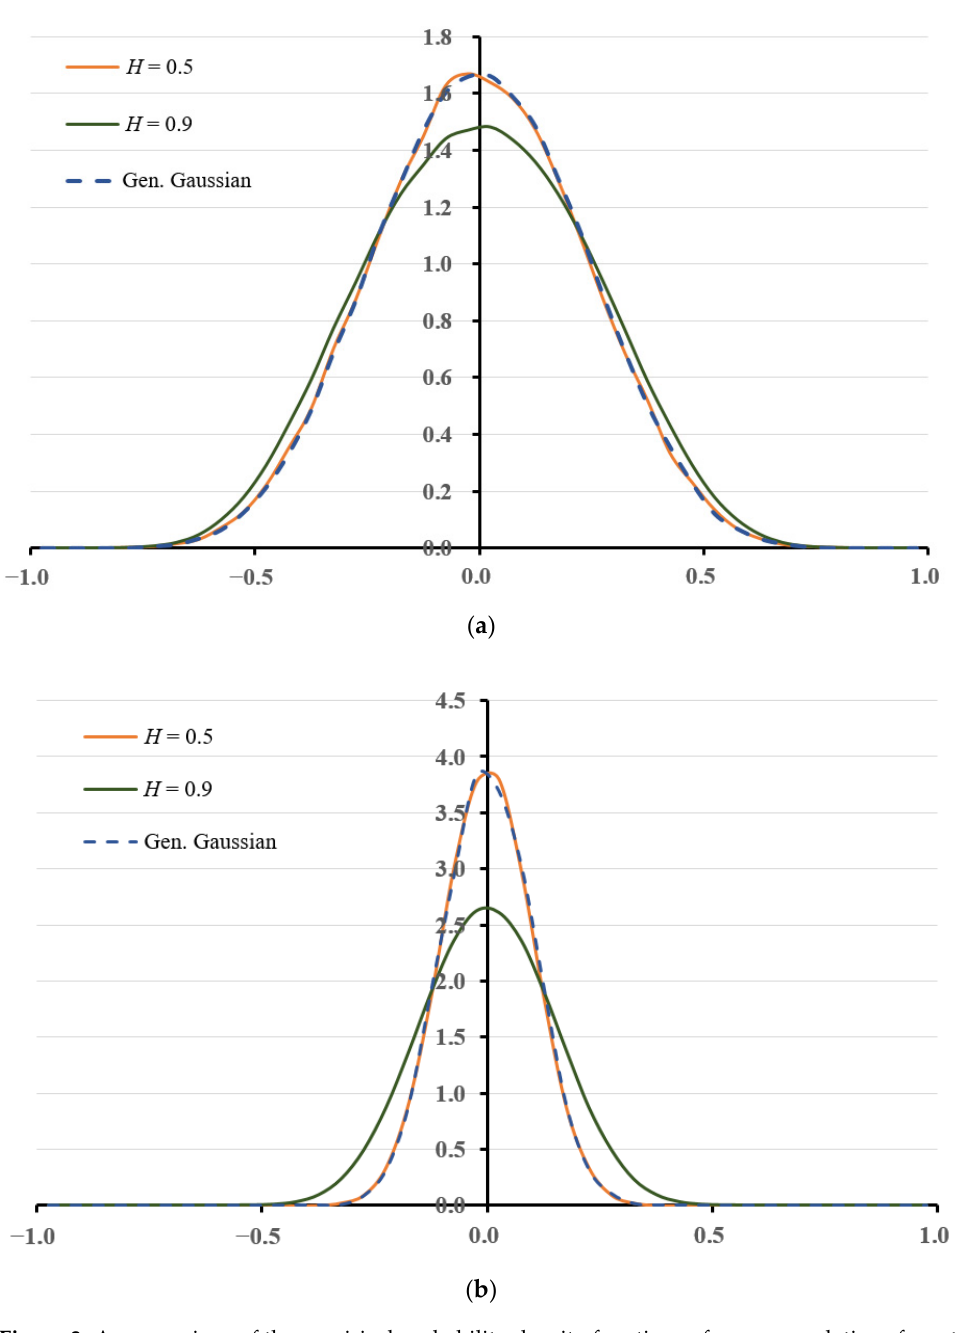
Figure 3. A comparison of the empirical probability density functions of cross–correlations from the LRD ‐ generated series (through the SMA algorithm), with H = 0.5 and 0.9, and n = 20 ( a ) and 100 ( b ).